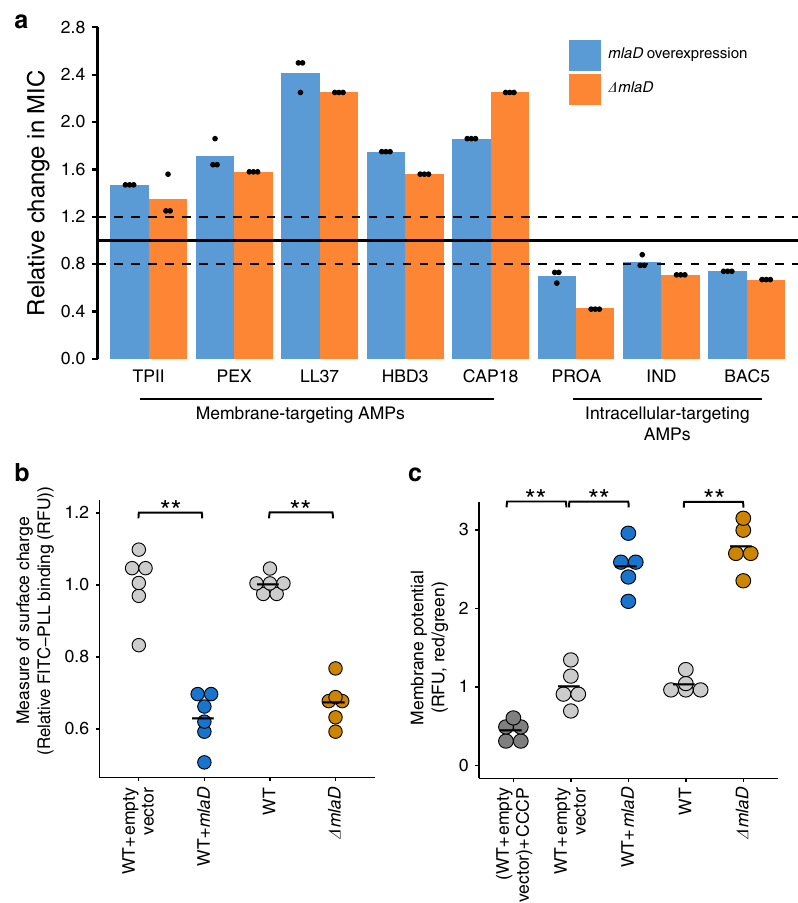
Fig. 5 Mutation in mlaD in fl uences AMP susceptibilities through antagonistic mutational effects. a Relative change in MICs of the mlaD overexpression and deletion strains ( Δ mlaD ) to a representative set of membrane-targeting and intracellular-targeting AMPs. MICs were compared to corresponding wild- type control strains (see Supplementary Figures 12, 13). Dashed lines represent previously de fi ned cut-offs for resistance ( ≥ 1.2 x MIC of the control) and sensitivity ( ≤ 0.8 x MIC of the control) 25 . b Decreased net negative surface charge of the mlaD overexpression and deletion strains. Signi fi cant differences: ** P = 0.0021 and P = 0.0021 for WT + empty vector vs overexpression and WT vs deletion strain, respectively, from two-sided Mann – Whitney U test, n = 6 biological replicates for each genotype. Charge measurement was done using FITC-labeled poly-L-lysine (FITC-PLL) assay where the fl uorescence signal is proportional to the binding of the FITC-PLL molecules. A lower binding of FITC-PLL indicates a less net negative surface charge of the outer bacterial membrane (see Methods). c Increased membrane potentials of the mlaD overexpression and deletion strains. Signi fi cant differences: ** P = 0.007, P = 0.0079 and P = 0.0079 for WT + empty vector CCCP control vs WT + empty vector, WT + empty vector vs WT + mlaD overexpression and WT vs. Δ mlaD , respectively, two-sided Mann – Whitney U test, n = 5 biological replicates for each genotype. Relative membrane potential was measured by determining relative fl uorescence (RFU) using a carbocyanine dye DiOC2(3) assay (see Methods). Red/green ratios were calculated using population mean fl uorescence intensities. WT E. coli carrying the empty vector treated with cyanide-m-chlorophenylhydrazone (CCCP, a chemical inhibitor of proton motive force) was used as an experimental control for diminished membrane potential. Central horizontal lines represent mean values of biological replicates. Source data are provided as a Source Data fi le and in Supplementary Fig.